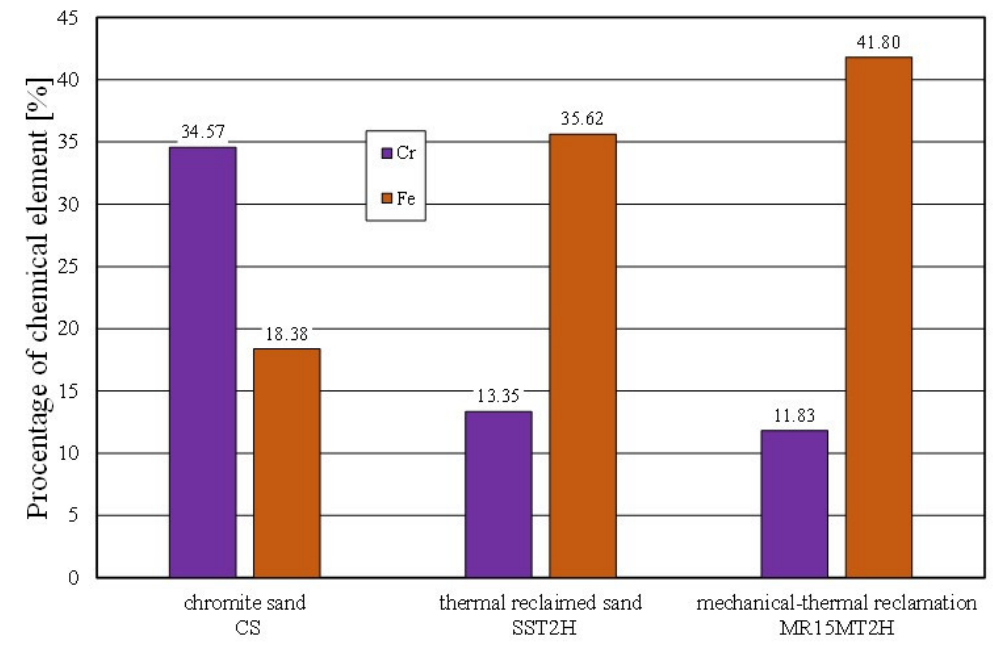
Figure 21. Comparison of chemical composition of grain matrix after thermal reclamation and grain matrix after mechanical–thermal reclamation.